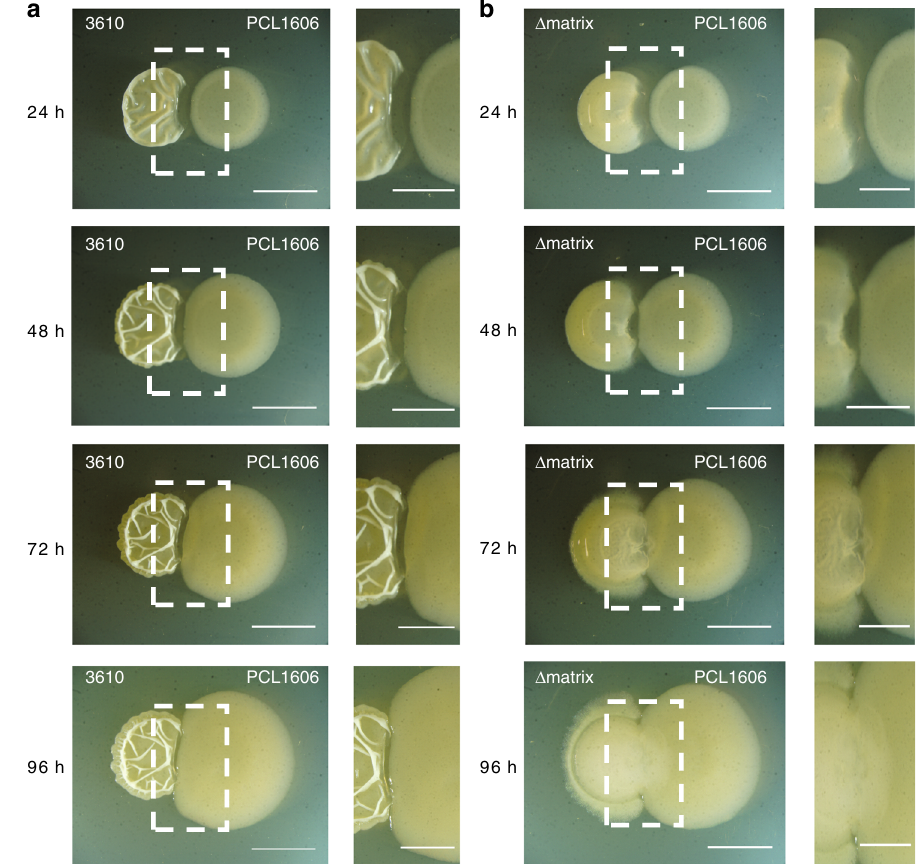
Fig. 1 The lack of B. subtilis extracellular matrix permits PCL1606 overgrowth. a , b Time-courses of the interactions a 3610 – PCL1606 and b Δ matrix – PCL1606 at 24, 48, 72, and 96h growing in LB medium. Close-ups of the intermediate areas are shown close to each time-point of the interaction. Left colonies are B. subtilis strains and right colonies are PCL1606. Scale bar = 5